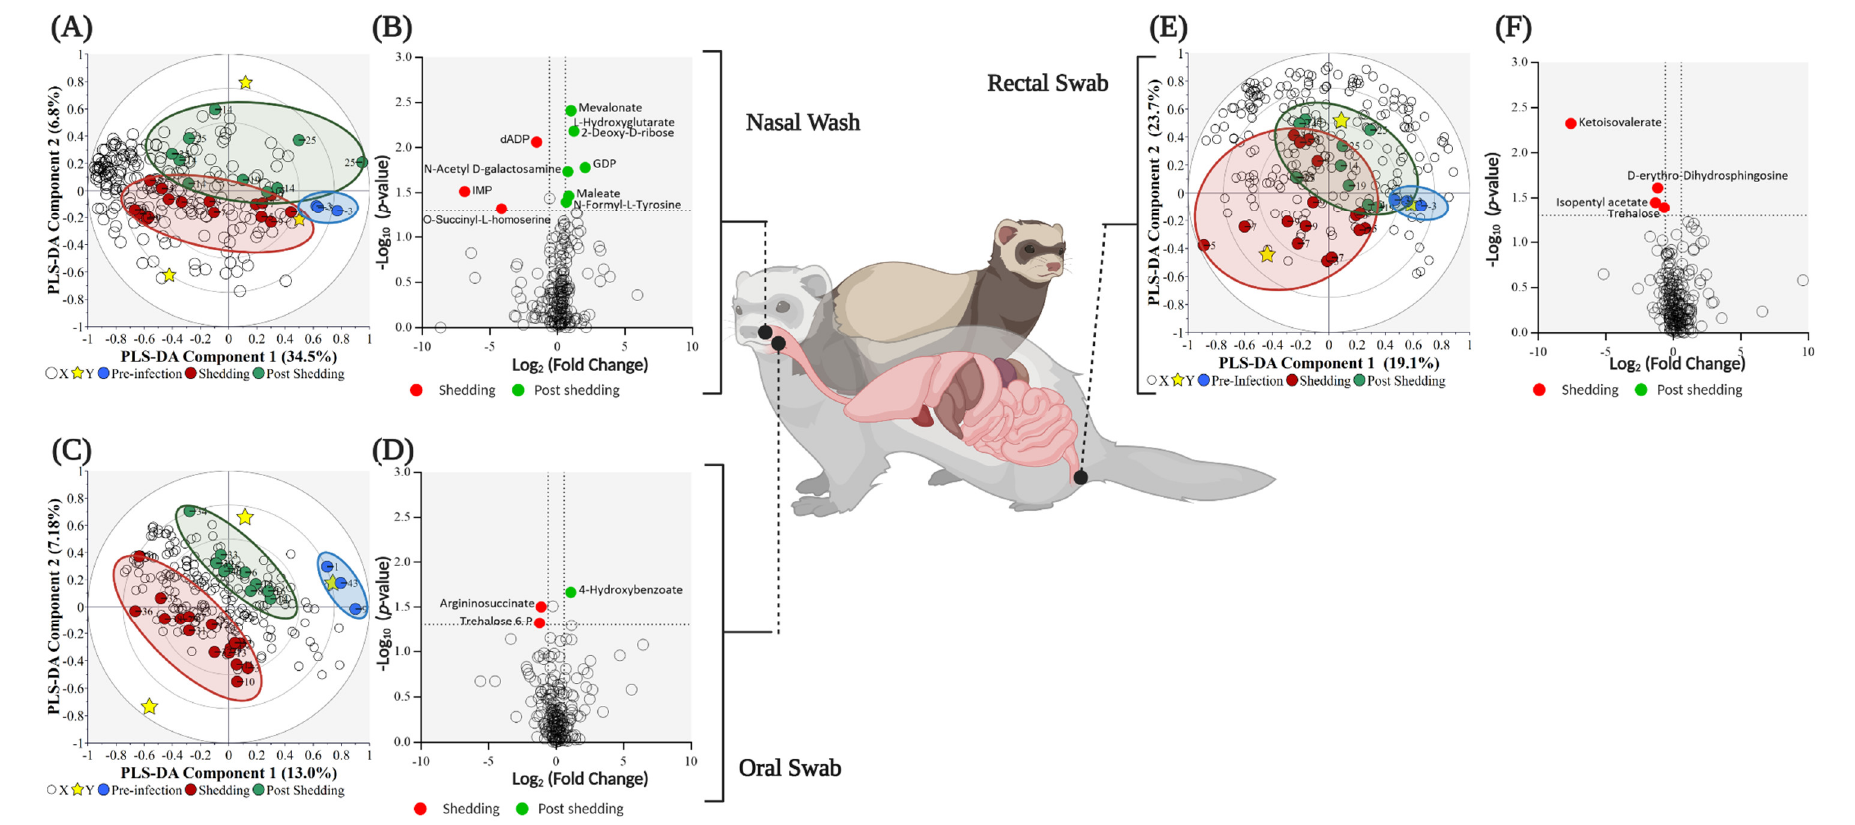
Figure 2. Biplot overview ( A , C , E ) of central carbon metabolism metabolites and associated volcano plots ( B , D , F ) of the significant metabolites using a fold change threshold of ≥1.5 or ≤0.66 and a p -value of ≤0.05. ( A , B ) nasal washes (R 2 X = 0.414, R 2 Y = 0.502, and Q 2 = 0.175); ( C , D ) oral swabs (R 2 X = 0.428, R 2 Y = 0.336, and Q 2 = −0.134), and ( E , F ) rectal swabs (R 2 X = 0.202, R 2 Y = 0.628, and Q 2 = −0.148). The ellipse on the biplots represent the 100%, 75% and 50% correlation coefficient for measured metabolites. For panels ( A , C , E ), the colored circles represent each analyzed sample, while the yellow-colored stars indicating the averaged group position for each sample cluster, and the white circles representing the distribution of central carbon metabolism metabolites between these groups. In the volcano plots (panels B , D , F ), the red circles represent significant metabolites identified during shedding, the green circles represent significant metabolites post-shedding, and the white circles represent the non-significant metabolites.